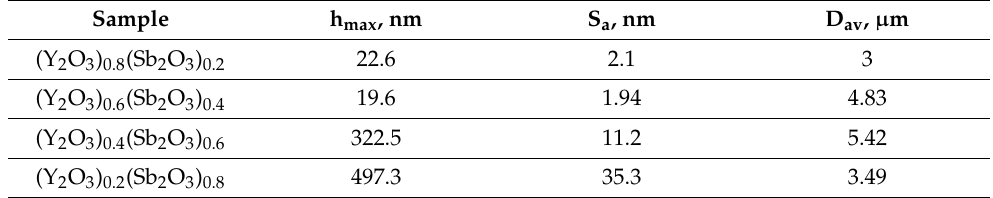
Table 2. Research data of thin films on a GaAs surface obtained by AFM method. Sample h max ,